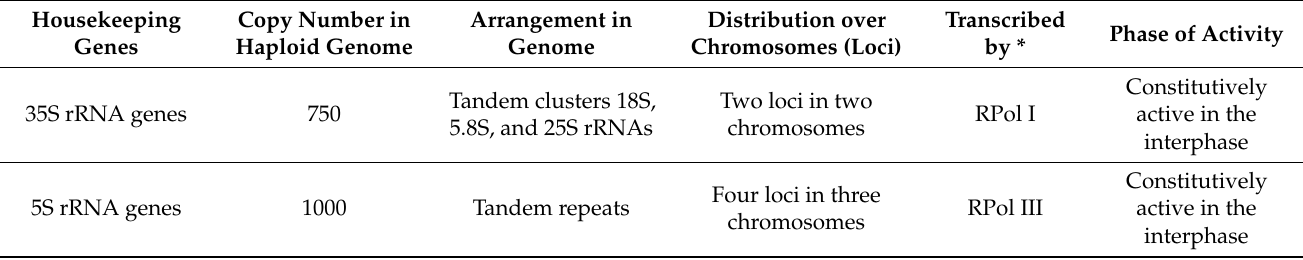
Table 1. Housekeeping genes of A. thaliana most promising for insertion of the genes coding for target recombinant